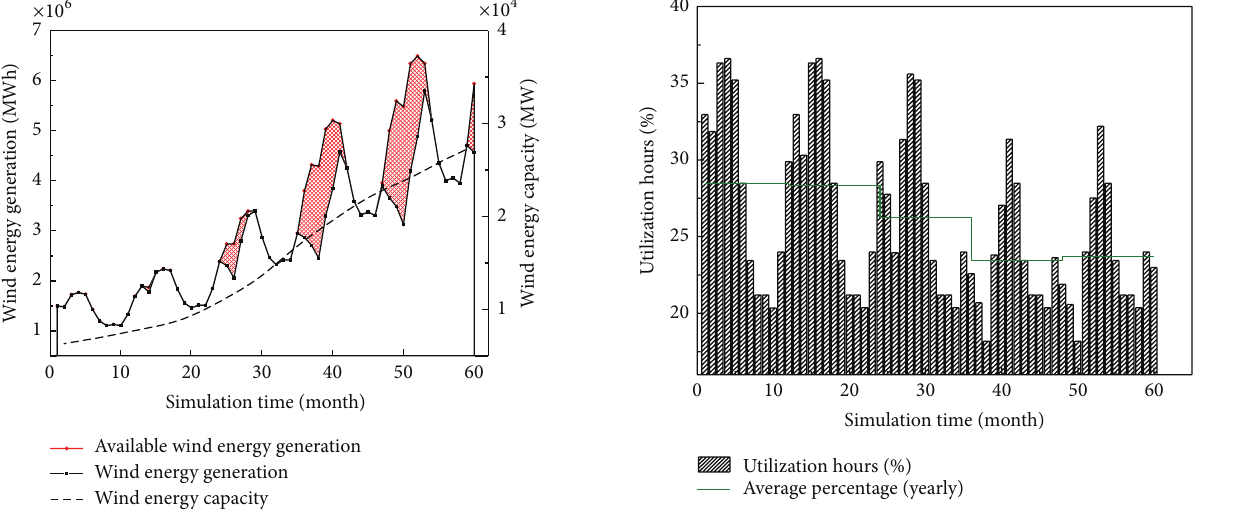
Figure 5: Multivariable trend chart of the optimal policy combina- tion (Combination H).